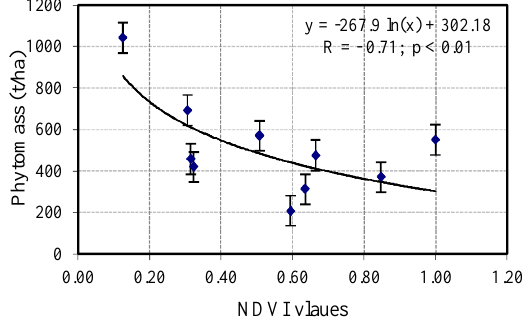
Figure 5. Regression of field based phytomass estimate (t ha -1 ) on December month NDVI